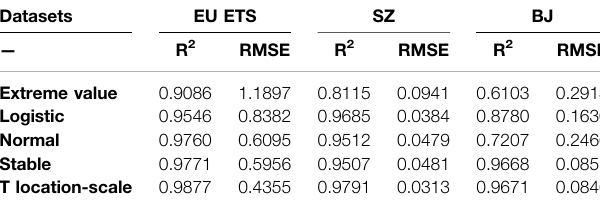
TABLE 9 | R 2 and RMSE values of the fi ve distribution functions by MLE.